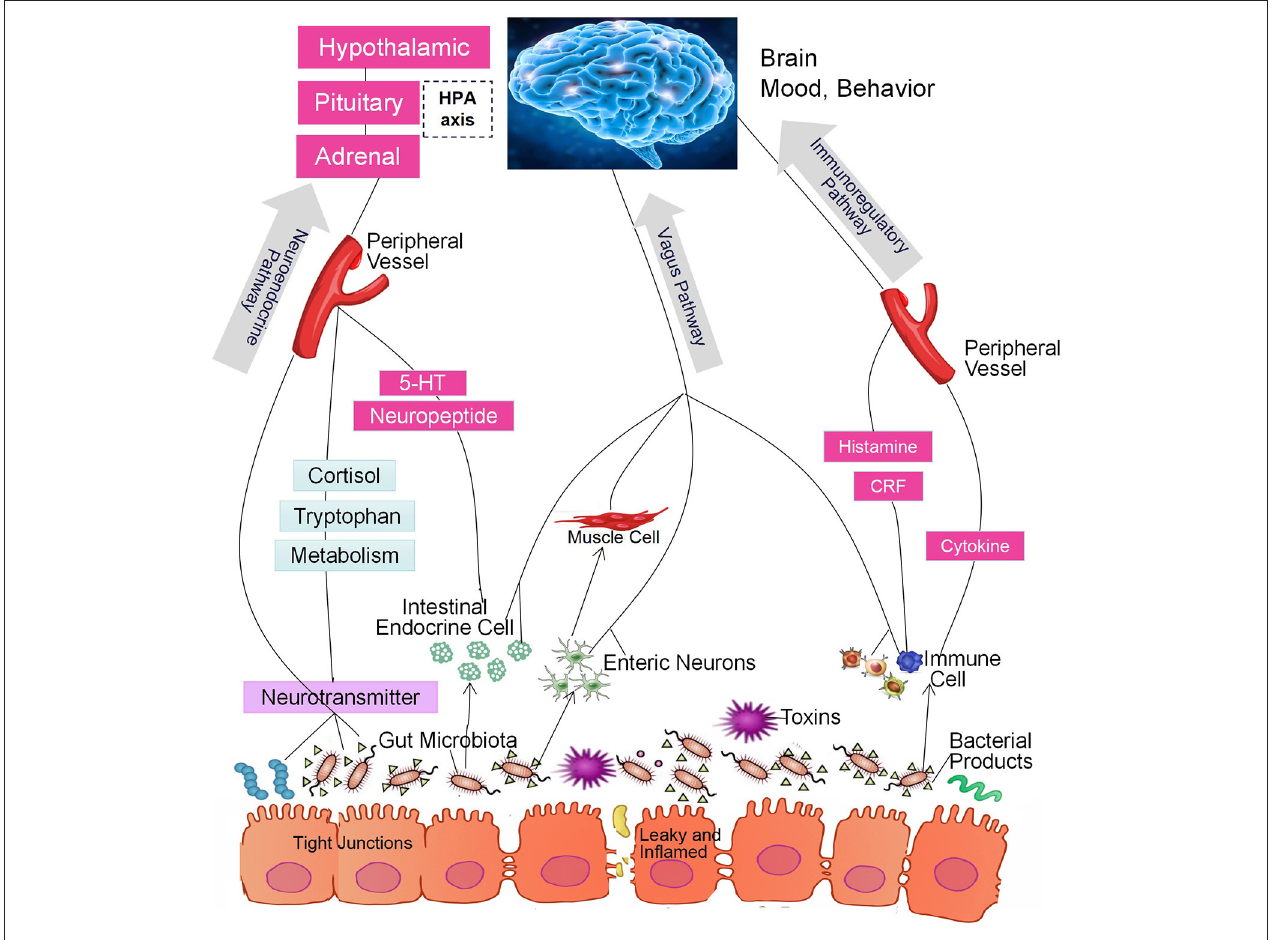
FIGURE 1 | The intestinal microbiota regulate brain function through the microbiome-gut-brain axis of the immunoregulatory, neuroendocrine, and vagus